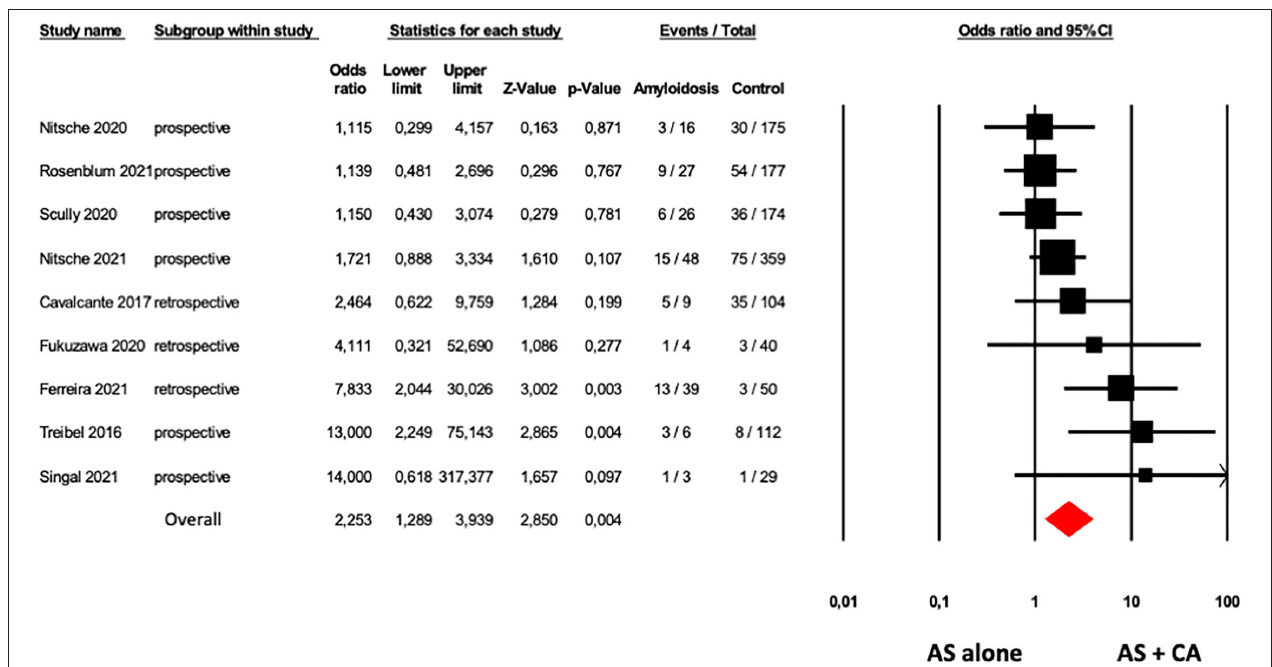
FIGURE 3 | Forest plots of overall mortality in AS patients with and without CA. Overall mortality was evaluated with the difference in Odds Ratio (OR) between AS patients with and without CA. The diamond represents the estimated overall effect, while the squares represent each study with